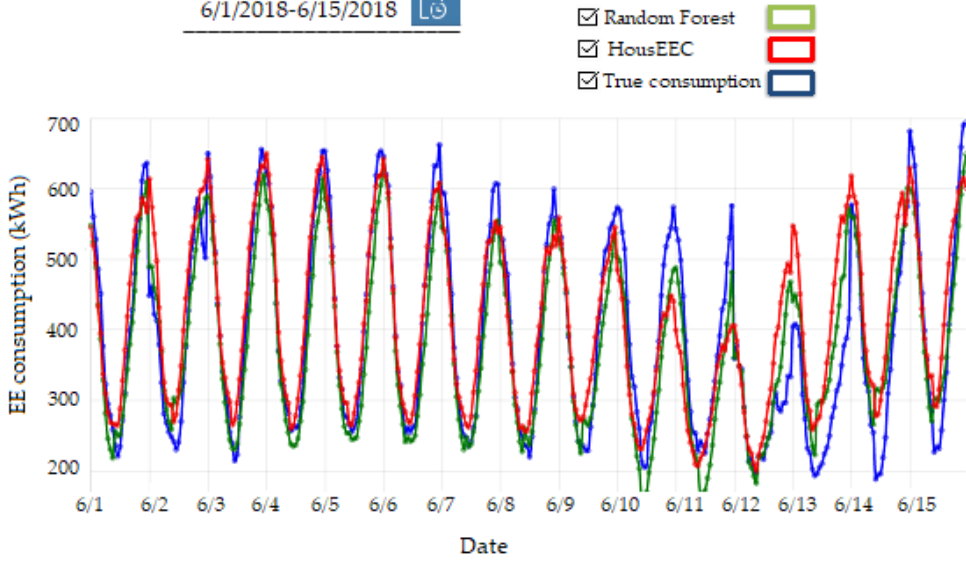
Figure 14. Historical performance comparison of predicted to true EE consumption.